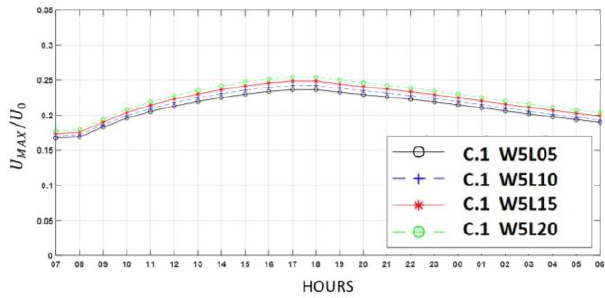
Fig. 4. Maximum nondimensional velocity U MAX /U 0 in the internal court of courtyard 1 versus time (hours of the day), for the different simulated courtyard dimensions (in the legend); U 0 is the undisturbed wind velocity.